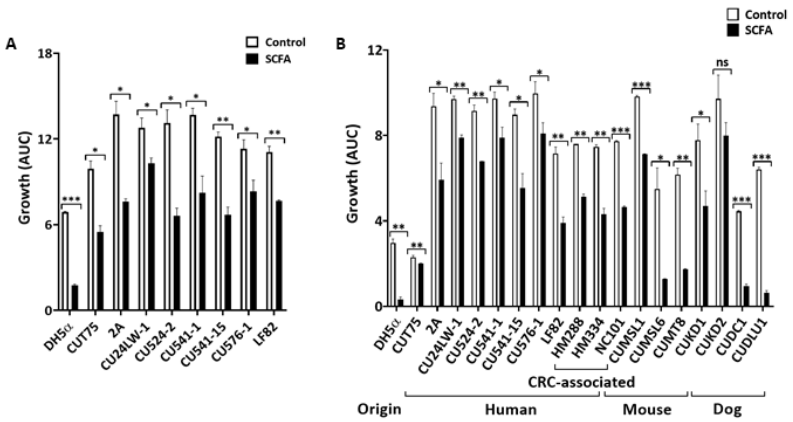
Figure 2. Colonic SCFA inhibit E. coli growth in vitro. E. coli were cultured in LB ( A ) or M9 ( B ) media containing either 123 mM NaCl (Control) or SCFA at pH = 6.5. Growth conditions were the same as for Figure 1. Data from three independent experiments; Mean ± SE. * p < 0.05; ** p < 0.01; *** p < 0.001; ns = not significant.